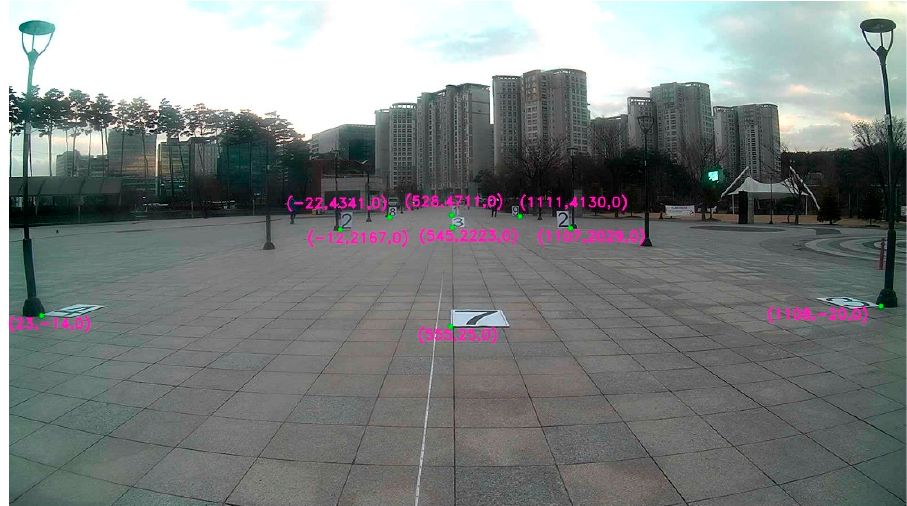
Figure 11. Result of calculating the world coordinates of the floor plan intersection point. Table 5. Floor projection intersection errors. Table5liststheerrorscalculatedbytheEuclideandistance The average error of the nine points was about 105